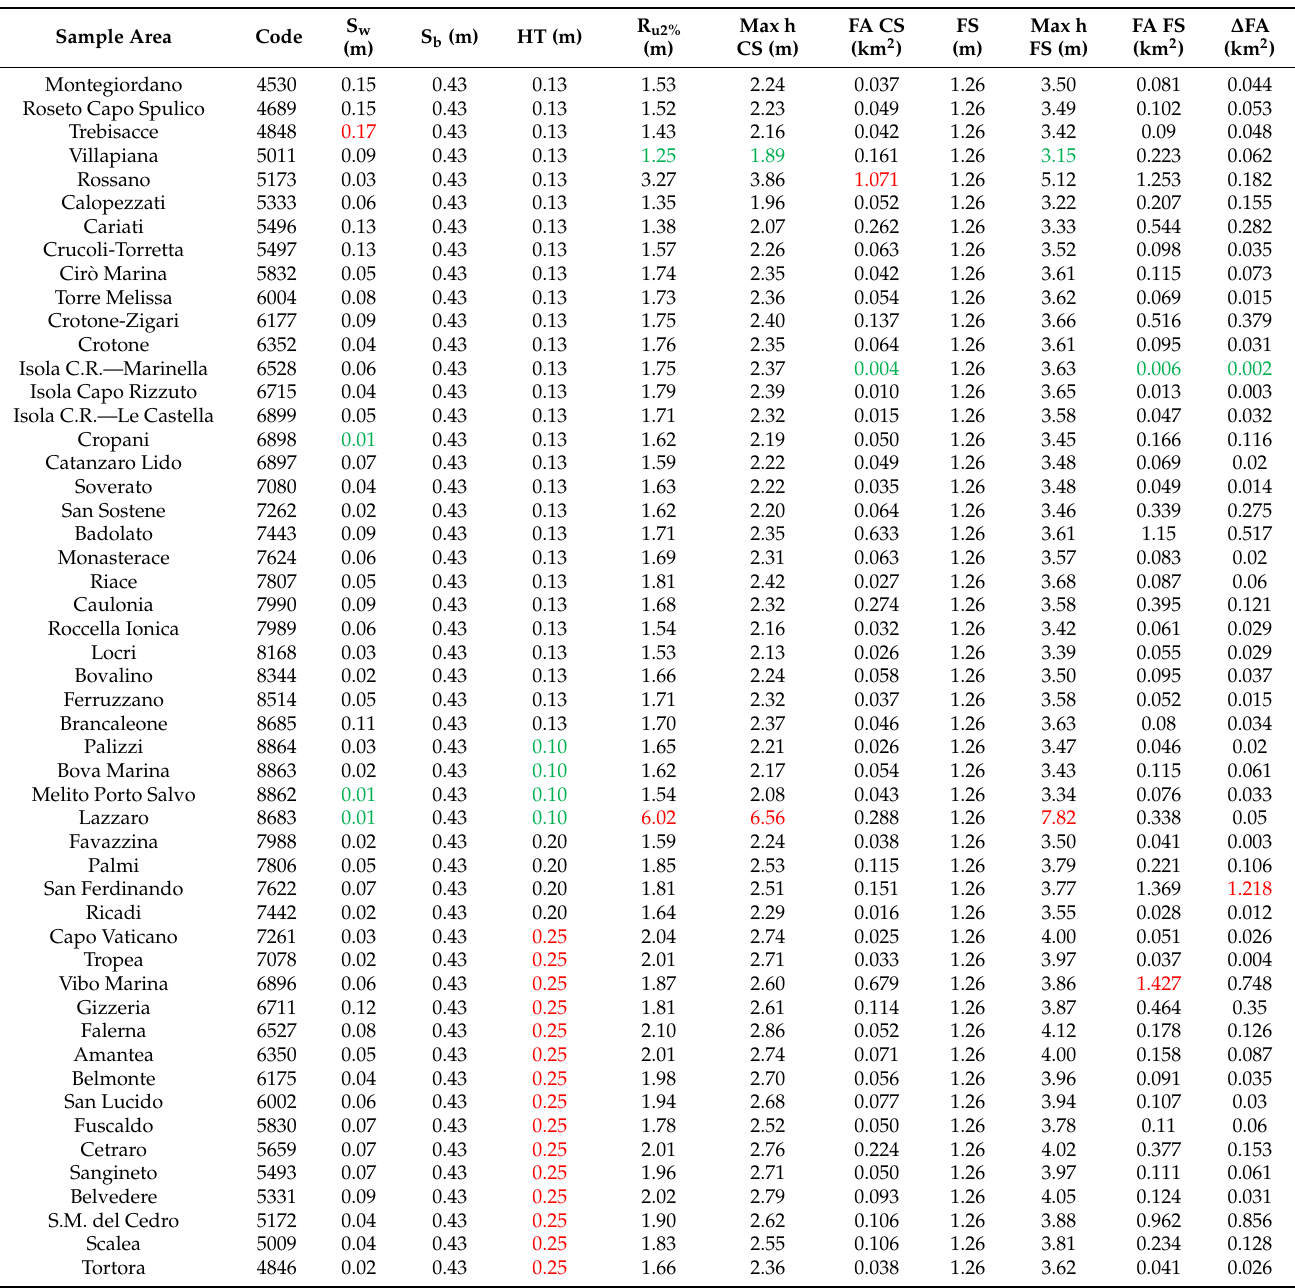
Table 1. Sample areas, related codes, and values of storm surge due to wind (S w ), storm surge due to barometric effect (S b ), high tide height (HT), wave run-up exceeded by 2% of the number of incident waves (R u2% ), maximum height reached by the water referred to the average sea level in current scenario (Max h CS), floodable area in current scenario (FA CS), SSP5-8.5 future scenario (FS), maximum height reached by the water referred to the average sea level in future scenario (Max h FS), floodable area in future scenario (FA FS), variations of floodable areas between current and future scenarios ( ∆ FA). Legend: The higher values are in red; the lower values are in green; S b and FS are constants, and therefore, are not